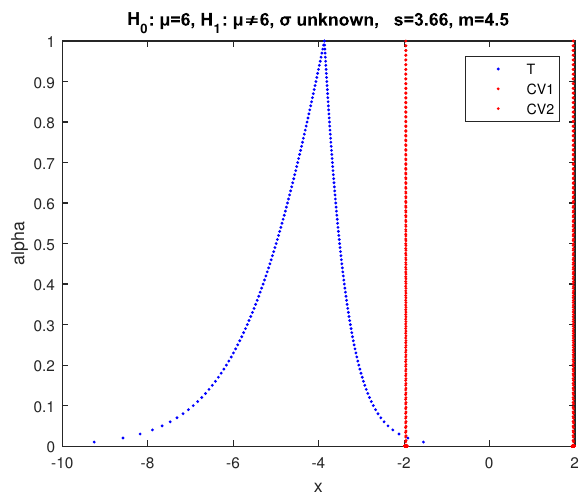
Figure 15. The fuzzy statistic T for the test of Example